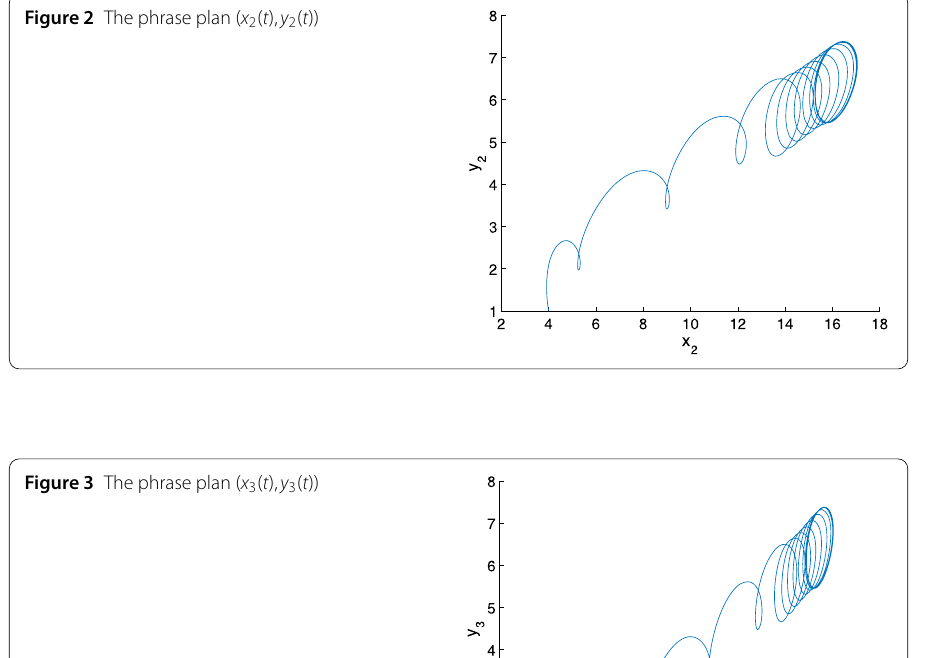
Figure 2 The phrase plan ( x 2 ( t ), y 2 ( t ))